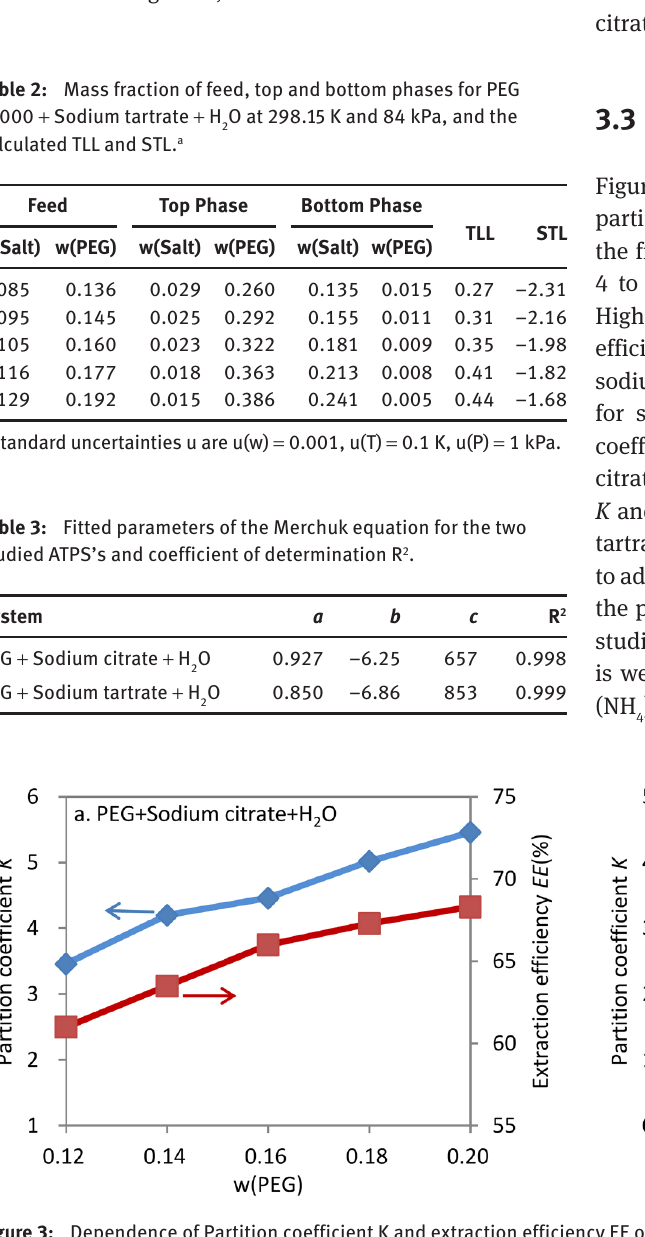
Figure 3: Dependence of Partition coefficient K and extraction efficiency EE on total mass fraction of PEG in ATPS of (a) PEG 10000 + sodium citrate + H O and (b) PEG 10000 + sodium tartrate + H O. The mass fraction of sodium citrate and sodium tartrate are 12%. 2 2